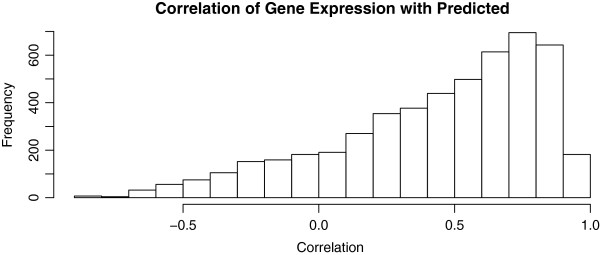
Histogram of correlations of the predictor YNg based upon regulatory network from databaseYD with gene expression in an independent experiment Y. The positivity of the center of the distribution implies a dependency of gene expression that is consistent with the OSRR model prediction.